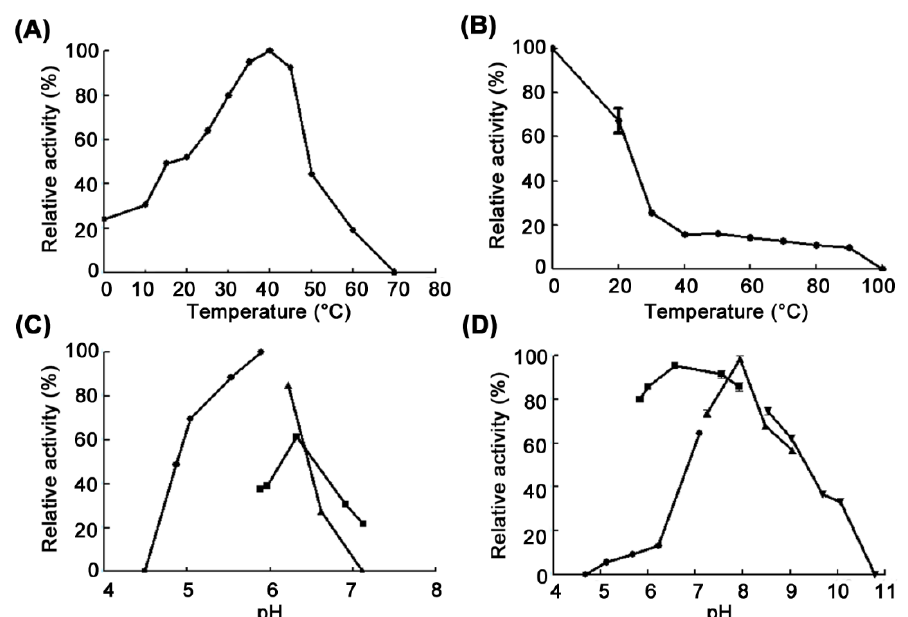
Figure 3. Effect of temperature and pH on the activity of CsnM. ( A ) Effect of temperature on the activity of CsnM. ( B ) Effect of temperature on the thermostability of CsnM. Residual activities were detected at 40 °C. The activity of the pre-incubated CsnM at 4 °C was taken as 100%. ( C ) Effect of pH on the activity of CsnM. The optimal pH was analyzed by detecting activity in sodium acetate buffer (pH 4.49 – 5.89, solid round), phosphate buffer (pH 5.88 – 7.12, solid square) and Tris-HCl buffer (pH 6.22 – 7.11, solid triangle). ( D ) Effect of pH on the stability of CsnM. The pH stability was determined